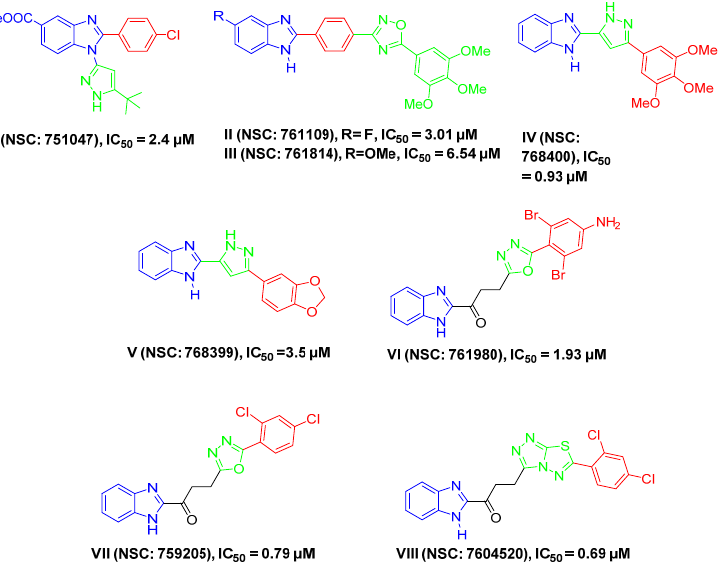
Figure 1. Structures of some reported benzimidazoles I – VIII , by other research groups, with anti-proliferative activity against triple-negative breast cancer MDA-MB-468 cells [22–27].